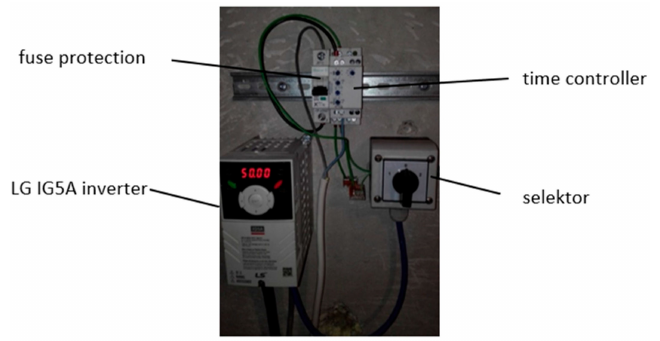
Figure 4. Automated control system for the fan.